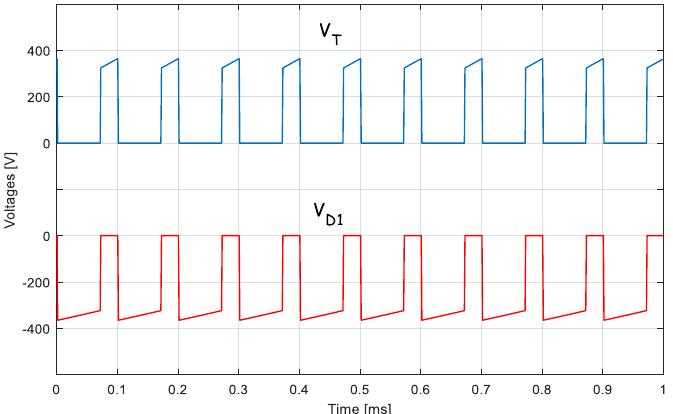
Figure 11. Simulation results of the voltage across the power switch S W and the diode D 1 in boost mode.